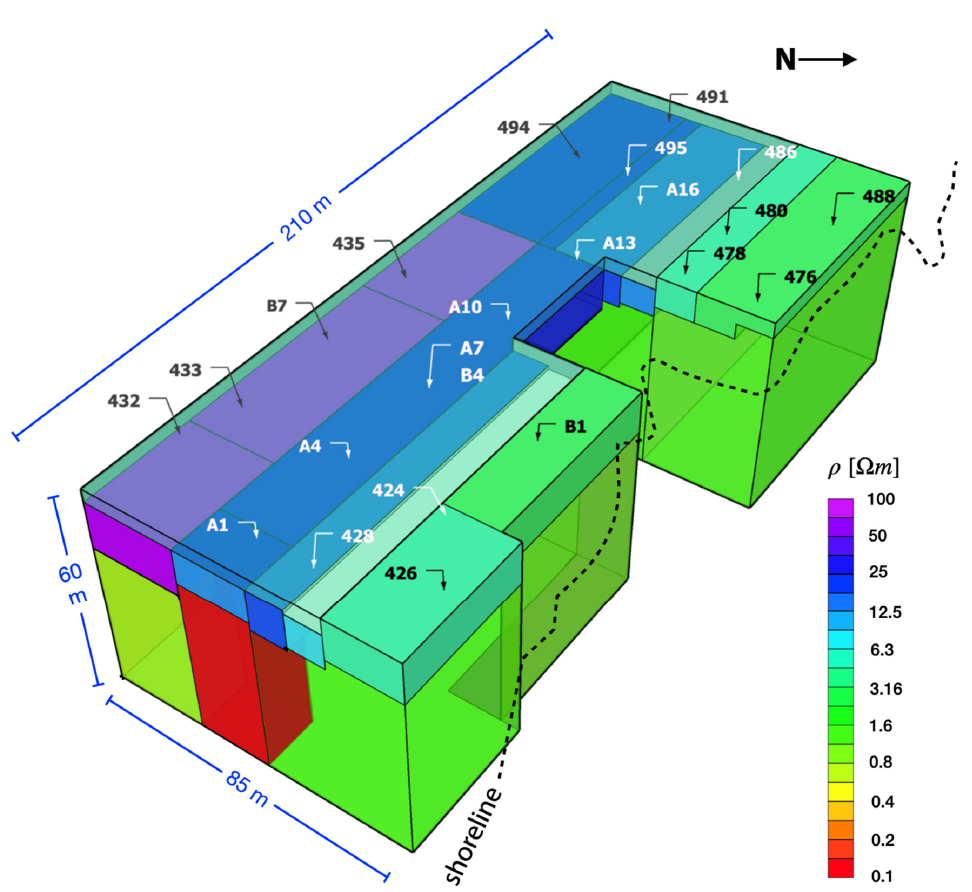
Figure 13. The preferred 3D model representing the subsurface geoelectrical structure beneath study site in SE Malta. Water 2020 , 12 , x FOR PEER REVIEW